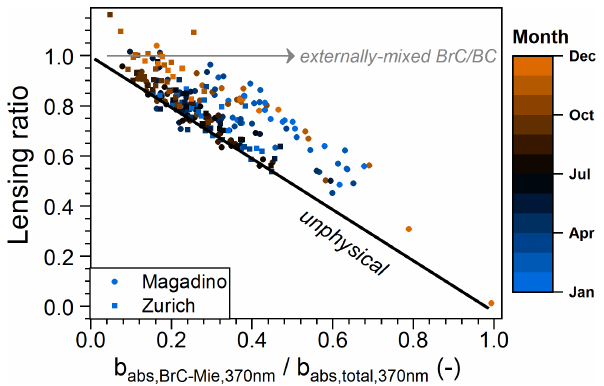
Figure 7. Relationship between the filter-based lensing ratio, E abs , 370nm /E abs , 660nm (Eq. 3; independent of MAC bareBC ), and the estimated average contribution of BrC to total absorption ( b abs , BrC − Mie /b abs , total ) at 370nm, showing that the extent of filter-based lensing suppression is related to the presence of BrC. The solid black line is the – x + 1 line below which data are physi- cally forbidden (where the + 1 intercept is based on the assumption that lensing by transparent shells is wavelength-independent). The addition of externally mixed BrC would result in an increase in the b abs , BrC − Mie /b abs , total without a decrease in the lensing ratio, as indicated by the grey arrow. As a consequence, points near the black line are theoretically impossible if a substantial fraction of BrC is externally mixed from